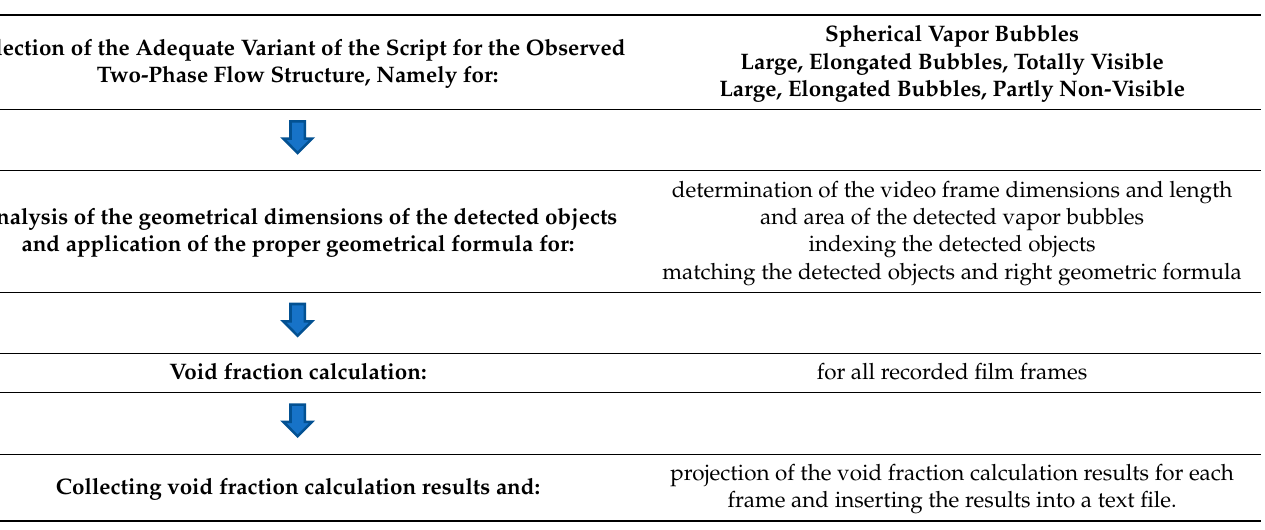
Table 1. Cont . Table 1. Global scheme of the Matlab script functioning.